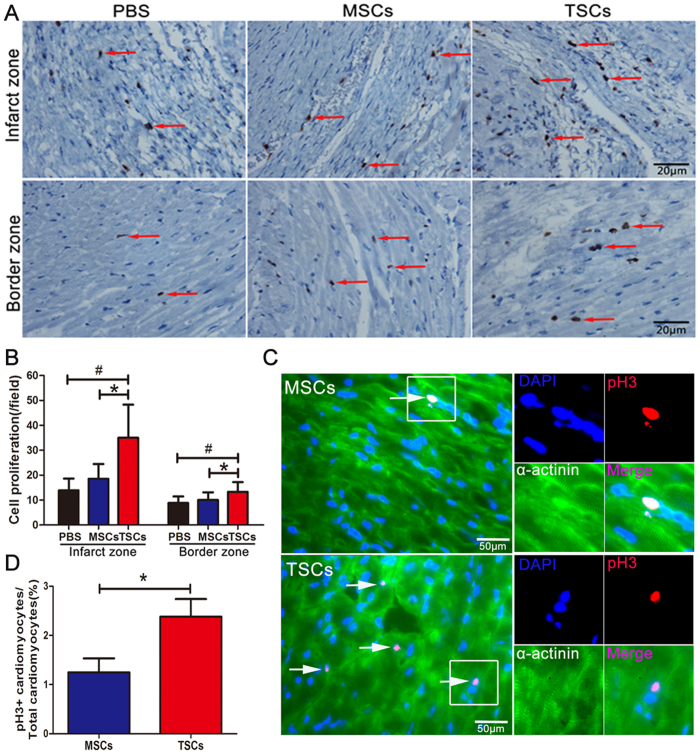
Cell proliferation after cell transplantation.(A) Representative Ki67-stained histological sections at 3-weeks after cell transplantation. (B) Quantification of Ki67+ cells showed that proliferating cells in the TSCs-engrafted groups were significantly higher than the MSCs-treated and PBS-treated groups both in the infarct and border zones; however, no difference was observed between the MSCs-treated group and PBS-treated group (n = 8 for each group). (C) Representative pH3-stained sections showed the proliferation of endogenous cardiomyocytes in the border zone at 3 weeks after cell transplantation. The boxed region is shown at higher magnification in the right panel. (D) Quantification of pH3+ cells showed that the endogenous proliferation cells in the TSCs-treated group were significantly higher than in the MSCs-treated group (n = 6 for each group) (Table S4). *P < 0.05, TSCs-treated group vs. MSCs-treated group; #P < 0.05, TSCs-treated group vs. PBS-treated group. Data are represented as mean ± SD.